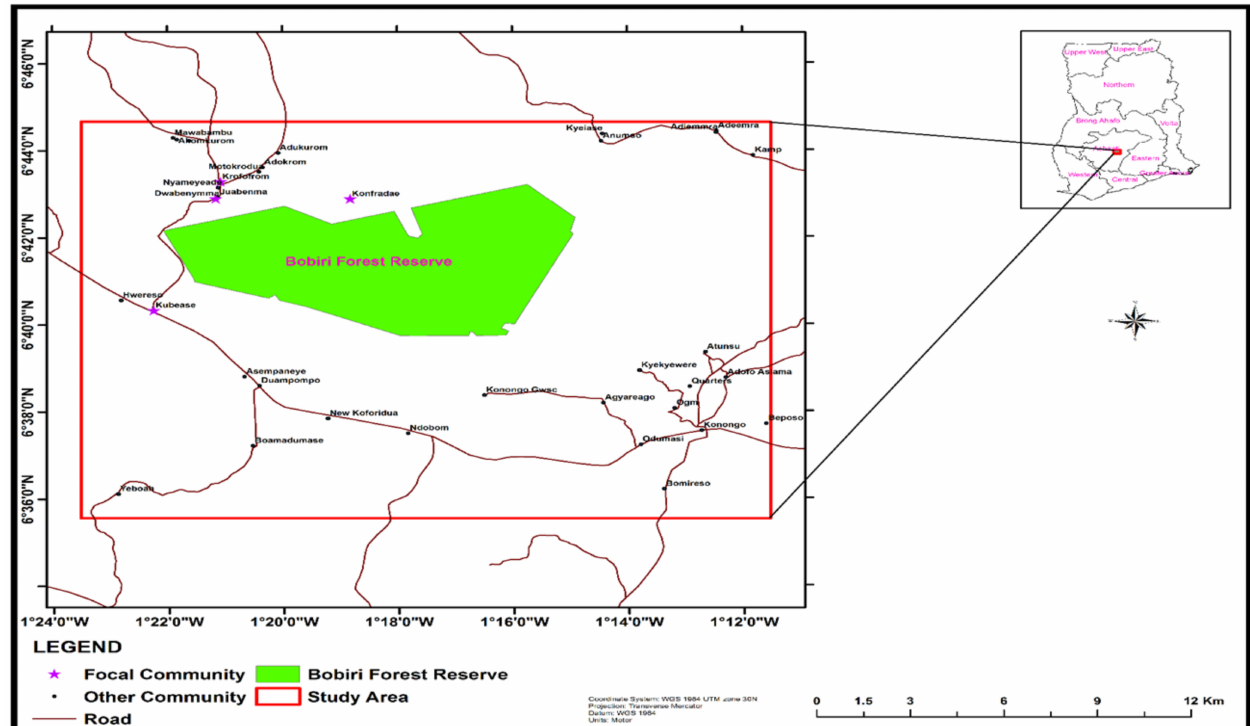
Figure 1. Map of Bobiri forest reserve showing the study